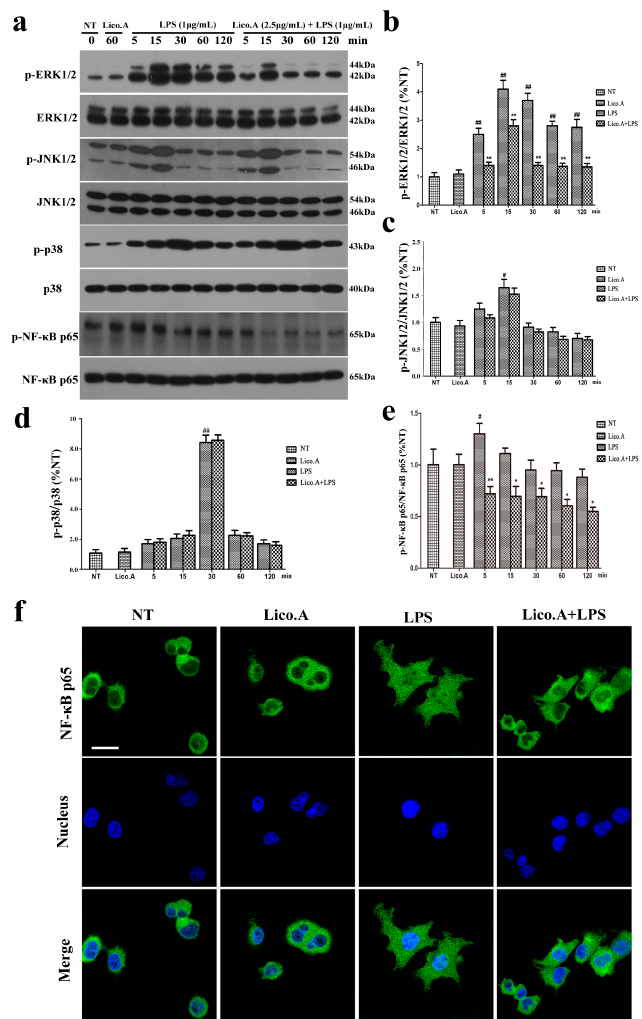
Figure 3. Lico.A suppresses extracellular signal-regulated kinase (ERK1/2) and nuclear factor κ B (NF- κ B) activation in LPS-stimulated BV-2 cells. ( a – e ) The phosphorylation of ERK1/2, JNK1/2, p38 and NF- κ B p65 was analyzed by Western blot. A representative immunoblot is shown. All the experiments were repeated at least three times and similar results were observed; ( f ) NF- κ B p65 nuclear translocation was inspected by ICC-IF assay. Representative photomicrographs of NF- κ B p65 subunit are shown. Scale bars, 50 µm. Values are mean ± SE, ( n = 5 samples/group). # p < 0.01, ## p < 0.001 vs. NT group; * p < 0.05, ** p < 0.01 vs. LPS group.